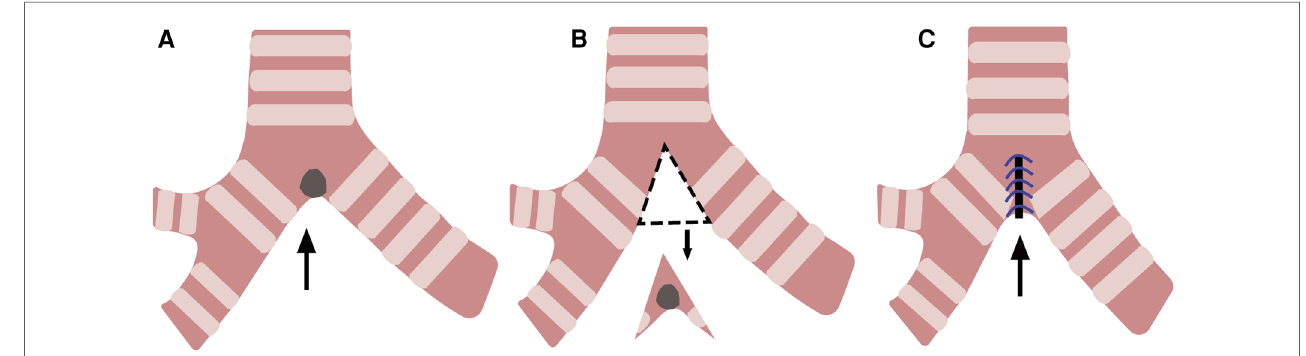
FIGURE 3 Wedge resection and reconstruction of the carina. ( A ) A tumor at the carina(arrow). ( B ) Resection of the tumor along the dotted line (arrow). ( C ) Reconstruction of the carina